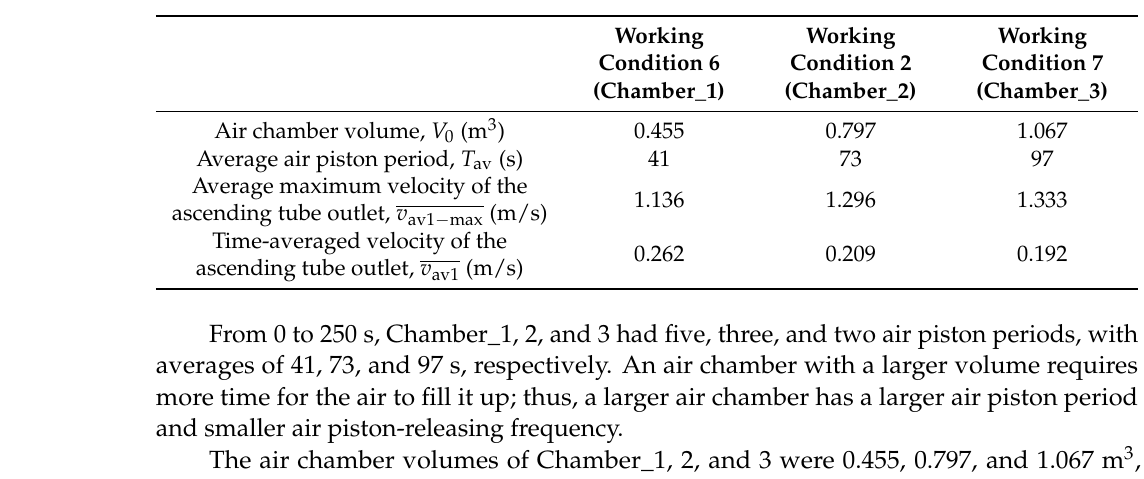
Figure 9. The velocity at the ascending tube outlet for different chamber volumes of ( a ) 0.455, ( b ) 0.797, and ( c ) 1.067 m 3 . The orange circles indicate the maximum velocities, and the red dashed lines indicate time-averaged velocities of the ascending tube outlet. Table 3. Computational results of the water-lifting performance with different air chamber